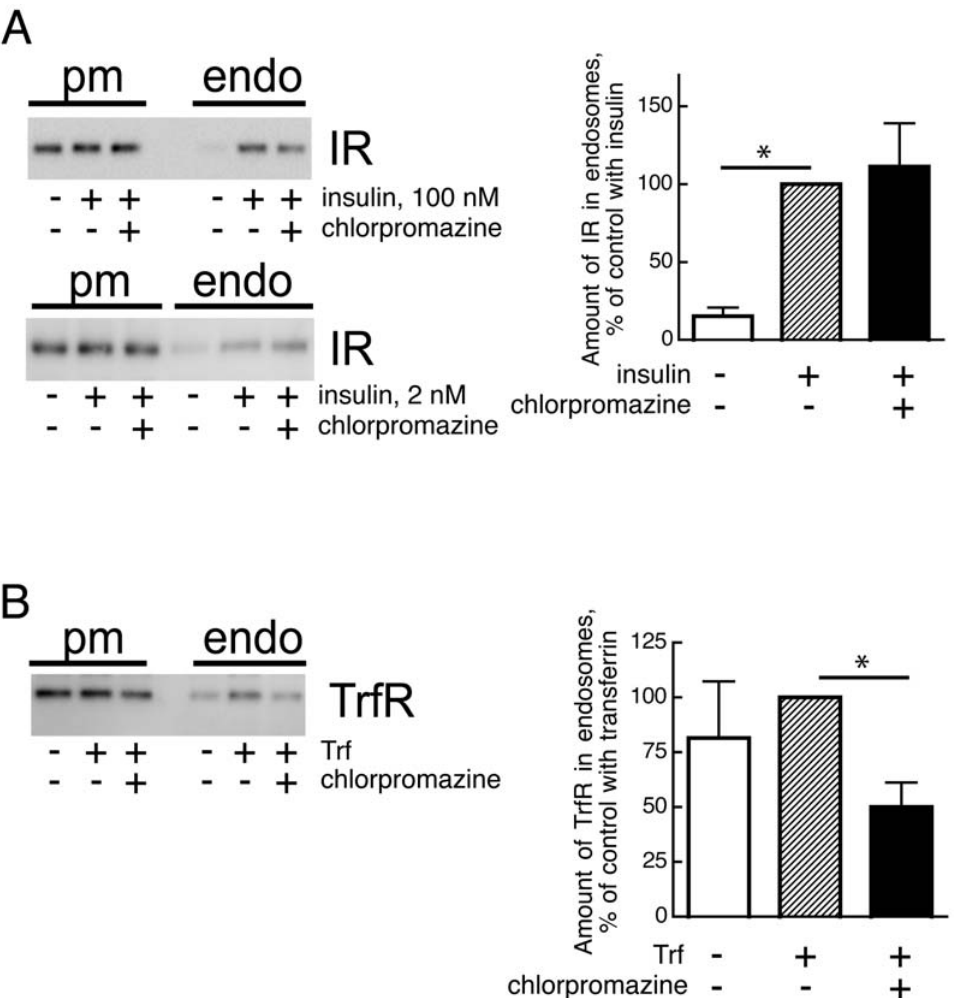
Figure6. Effect of chlorpromazine oninsulinreceptor andtransferrinreceptor endocytosis. Isolated adipocytes were incubated with 50 m M chlorpromazine for 20 min when insulin at 100 nM ( A ), or transferrin (Trf) at 25 m g/mL ( B ) was added for another 10 min. Cells were then homogenized and plasma membrane (pm) and endosomal fractions (endo) isolated. Equal amounts of protein were subjected to SDS-PAGE and immunoblotting with antibodies against theinsulin receptor b -subunit (IR) ( A ) or transferrin receptor(TrfR) ( B ). Results areexpressedas amountof IRin the endosomalfraction as % of insulin-treated controls without chlorpromazine, mean 6 SE of 4 separate experiments ( A ); or as amount of TrfR in the endosomal fraction as % of transferrin-added controls without chlorpromazine, mean 6 SE of 4 separate experiments ( B ). *, p , 0.05 by Student’s